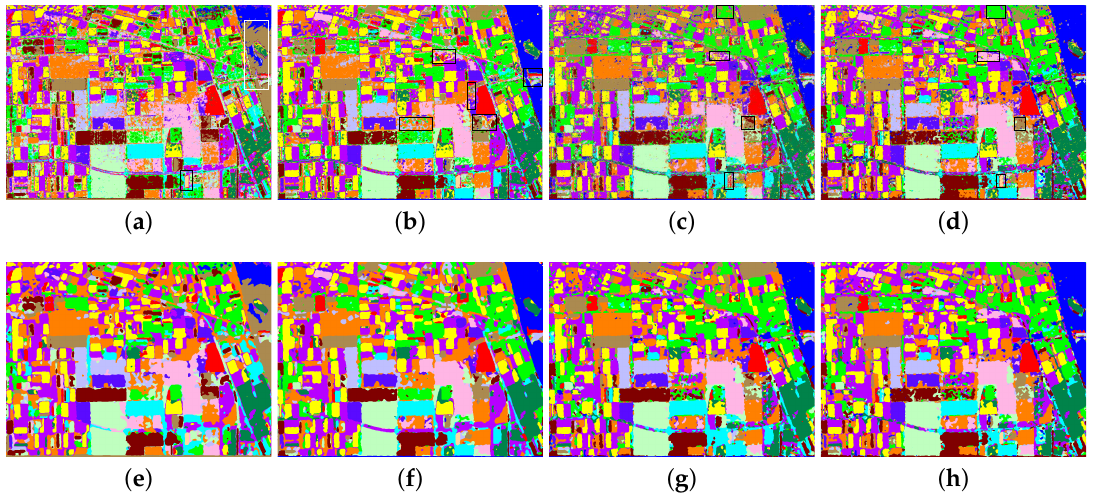
Figure 6. Prediction result of Flevoland image obtained by different methods, including: ( a ) Wishart classifier; ( b ) SVM; ( c ) classification network based on AE; ( d ) classification network based on the proposed MAE; ( e ) Wishart classifier with PP step; ( f ) SVM with PP step; ( g ) AE with PP step; and ( h ) MAE with PP